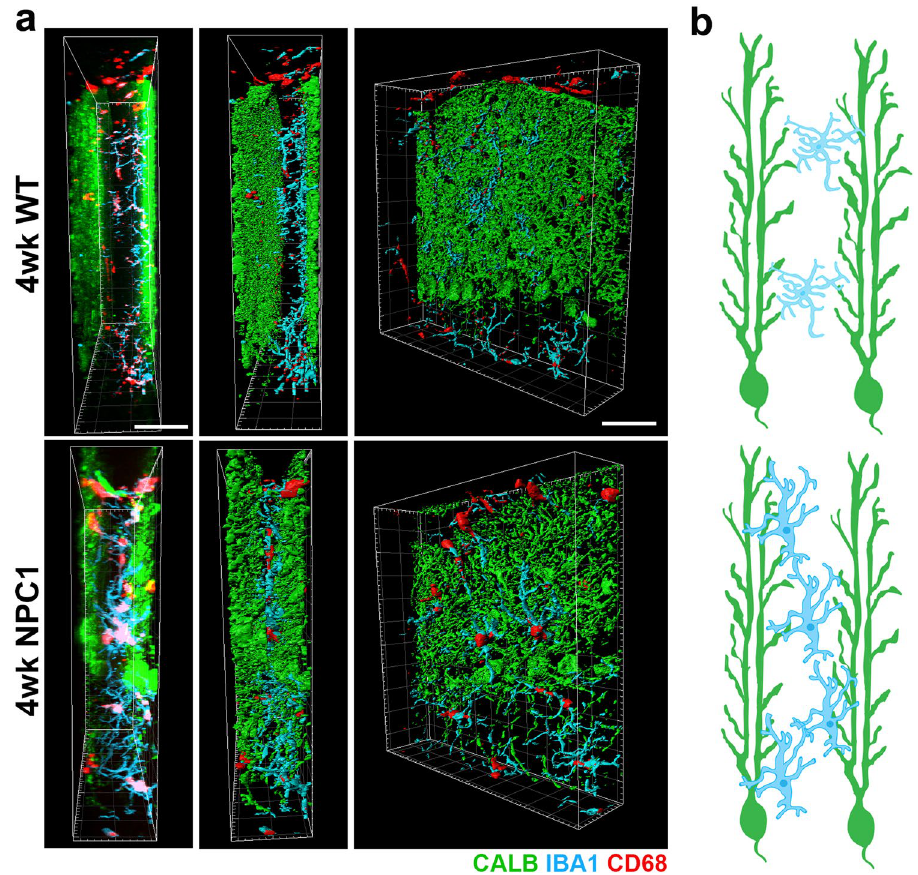
Figure 5. Microglia at the ML reside in the medio-lateral space between single monoplanar PC layers (PCL). ( a ) Medio-lateral views of 3D confocal and 3D surface rendering images of the ML from WT and Npc1 nmf164 mice immunostained with IBA1(cyan), CD68 (red) and CALB (green). The PCL of the left was removed in the surface rendering Images of the third column to show the location of microglia (red and cyan) relative to the PCL at the right (green). ( b ) Representative diagram of the microglia location and distribution when observed from a medio-lateral view. At 4 weeks of age, more overlapping of activated microglia with the PCL was observed in Npc1 nmf164 mice. Scale bars: 40 μ